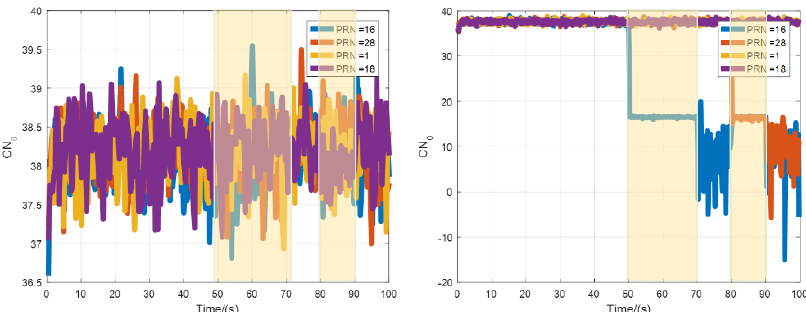
Figure 10. The C/N 0 values of different channels of satellite signals.